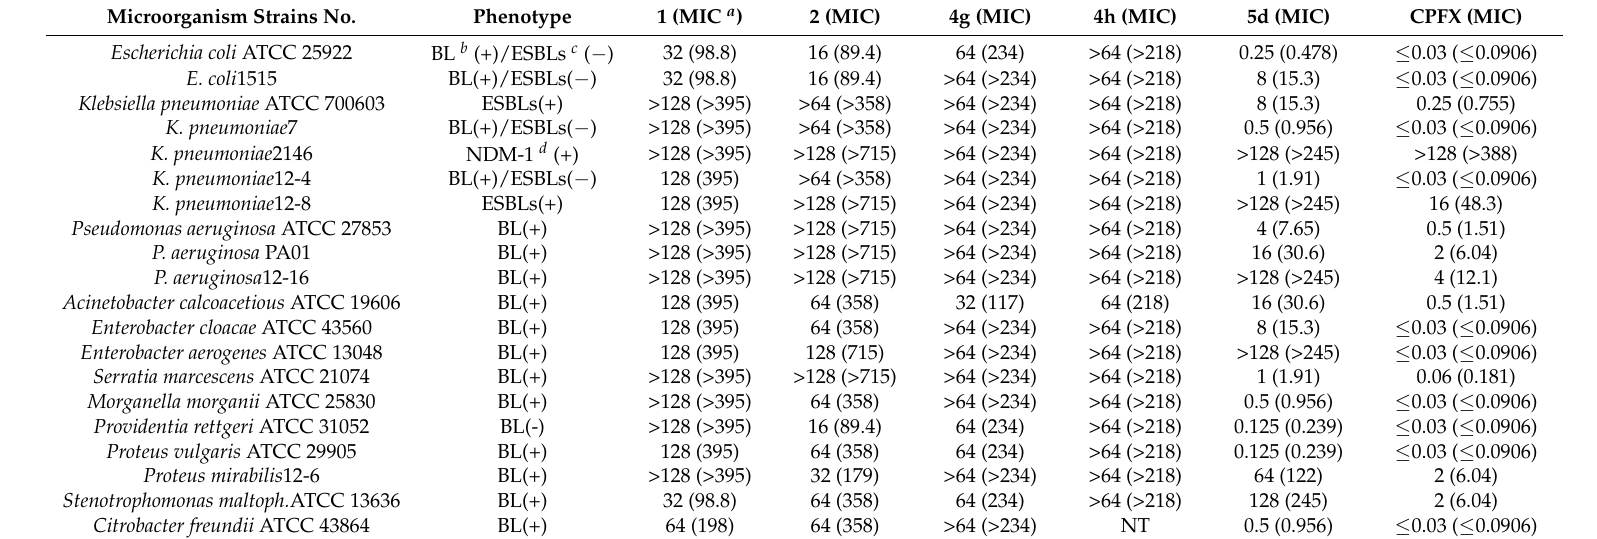
Table 2. In vitro activities against G − bacteria of candidates 4g , 4h , and 5d